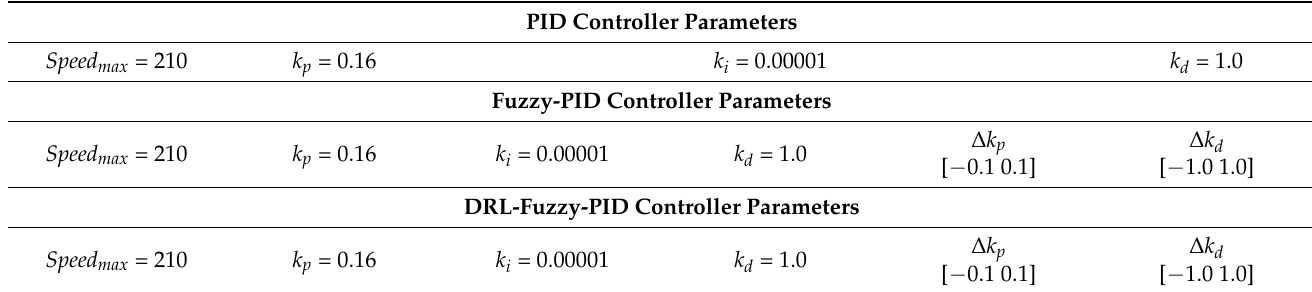
Table 2. Parameter design of conventional PID, Fuzzy-PID, and DRL-Fuzzy-PID control in step response.